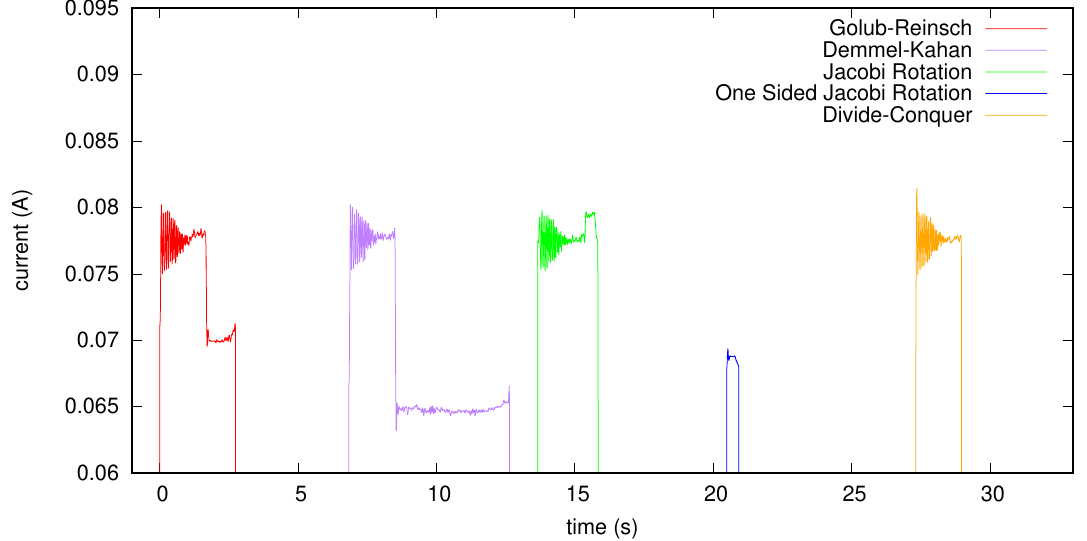
Figure 7. Current consumption of SVD algorithms on Cortex-M4F for the 96 × 72 matrix, low-pass